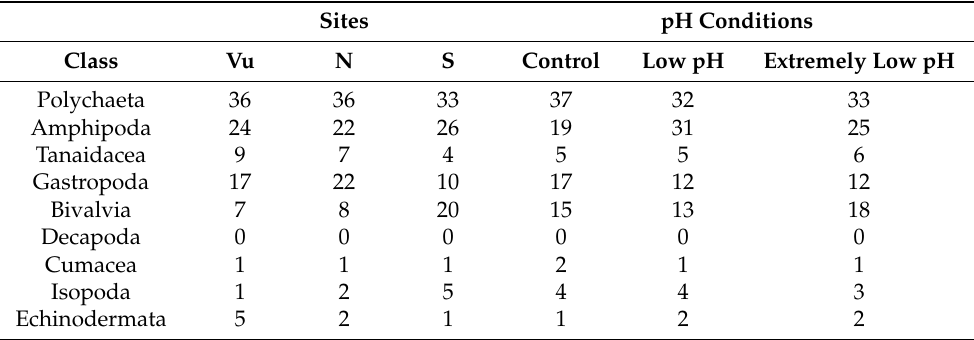
Table 1. Composition of the benthic organisms collected in the samples in different sites and pH conditions and expressed as percentages (%) of each taxonomic group on the total number of individuals sampled. Sites pH Conditions Class Vu N S Low